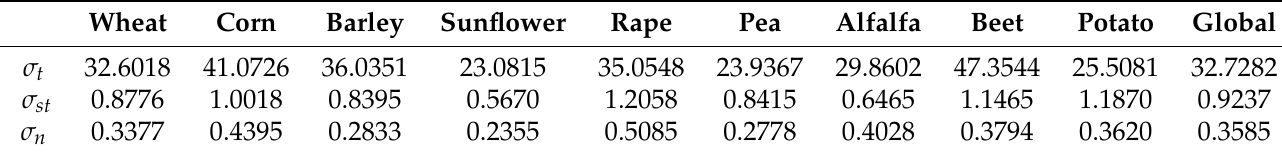
Table 3. Averaged hyperparameters estimated using fixed crop-type and global approaches : σ t defines the gap-filled time series smoothness, σ st is the amplitude scaling factor and σ n accounts for the noise variance.